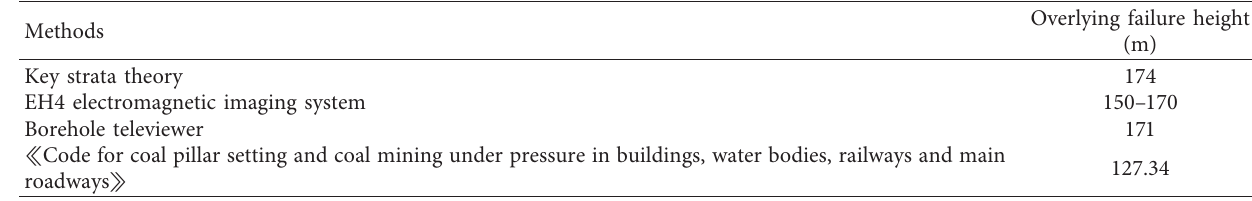
Table 5: Comparison of overlying failure height determined by different